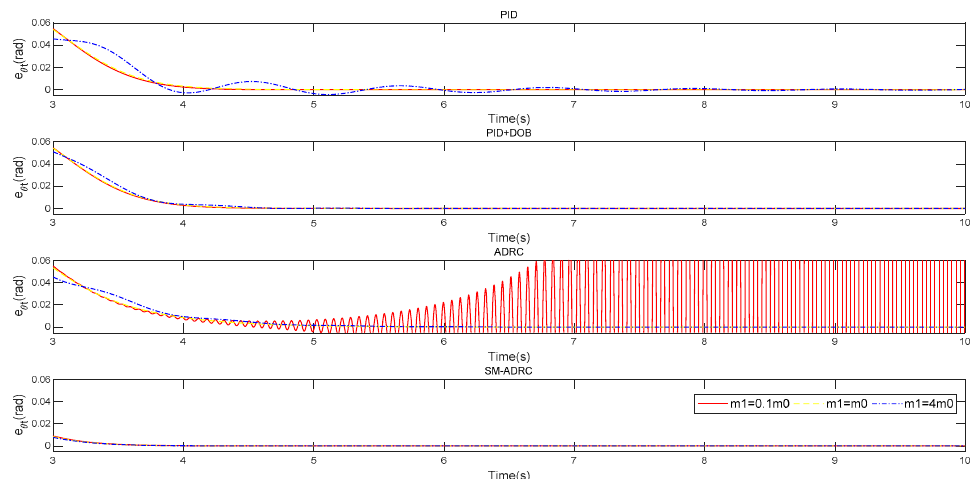
Figure 6. Tracking error trajectories of the flexible manipulator tip position with different tip mass values.